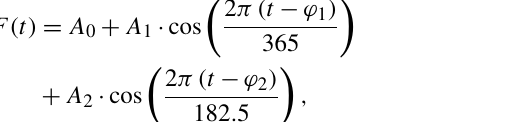
Figure 4. Diurnal variability for different seasons. The colours in- dicate the emitter: FeO (red squares), Na (cyan triangles). The sym- bols are placed at the mean time of all the measurements in each bin with respect to midnight. The ordinate shows the intensities relative to the nocturnal